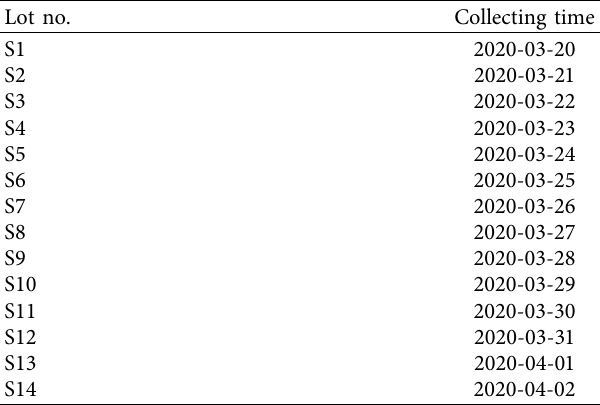
Table 1: Information of samples of A. persica flowers. Lot